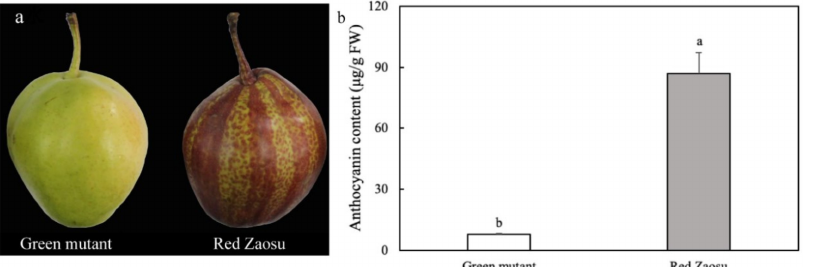
Figure 6. Anthocyanin accumulation in ‘Red Zaosu’ and its green mutant. ( a ) Fruit skin color of ‘Red Zaosu’ and its green mutant. ( b ) Anthocyanin content in ‘Red Zaosu’ and its green mutant. 3.5. Expression of Genes Involved in Anthocyanin Biosynthesis in Ripe Fruits of ‘Red Zaosu’ and Its Green Mutant